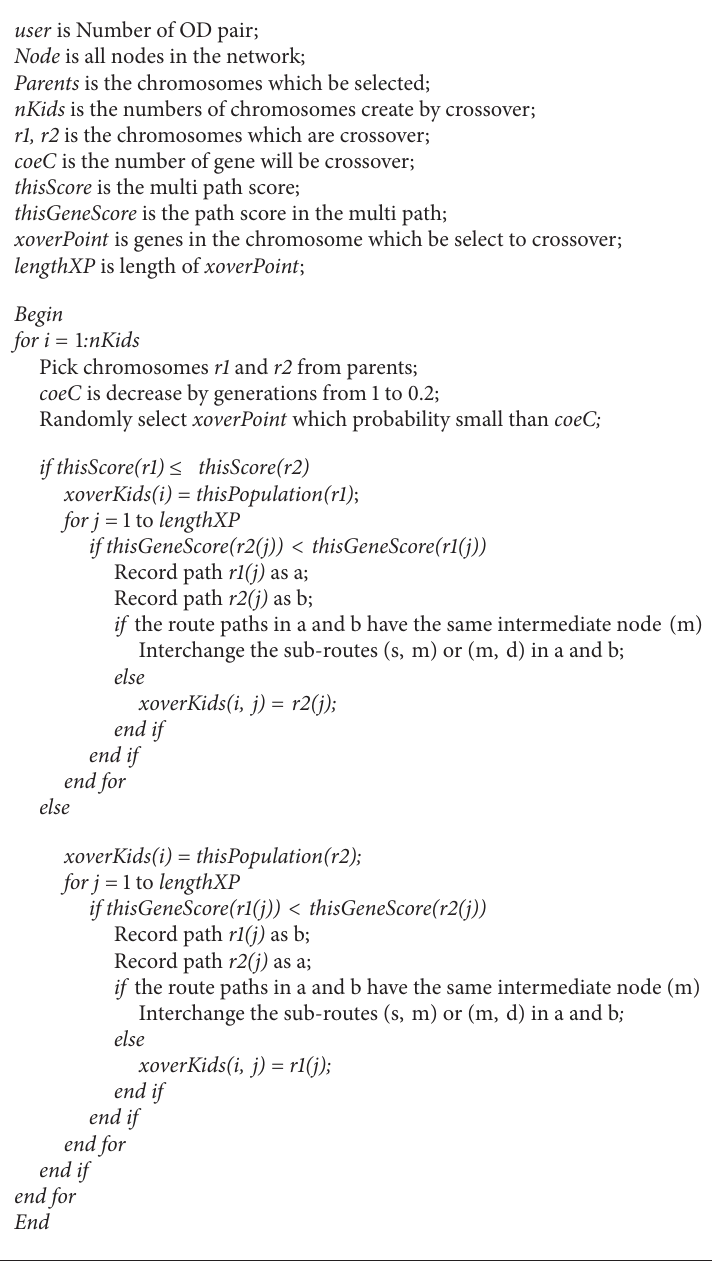
Pseudocode 1: Pseudocode of the crossover operation for routing